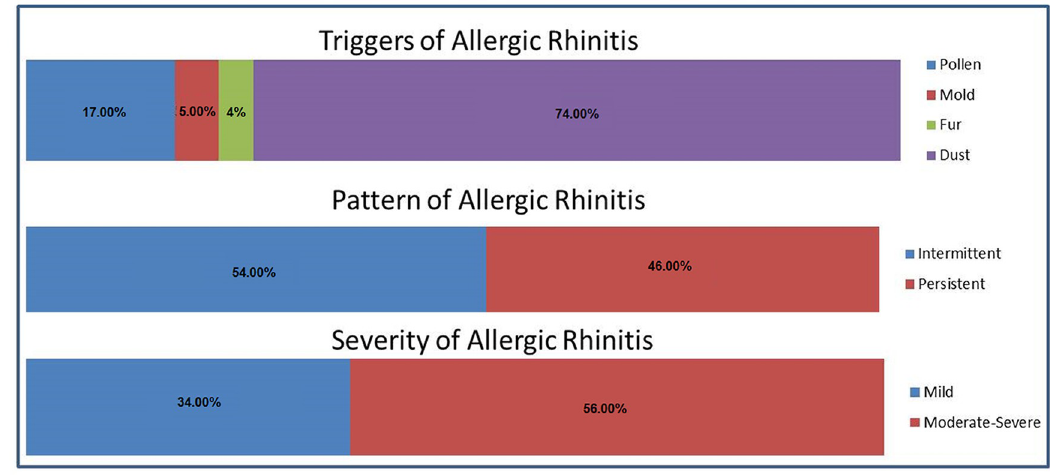
Fig 1. Allergic rhinitis characteristics.